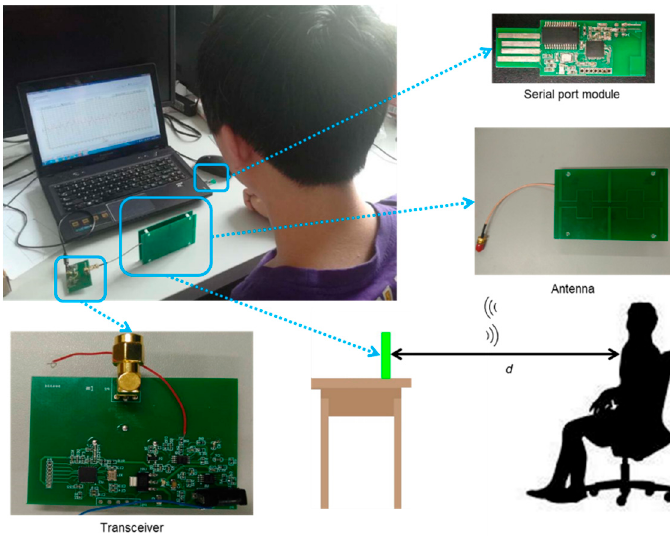
Figure 8. The experiment scene and devices (transceiver, serial port module and antenna).